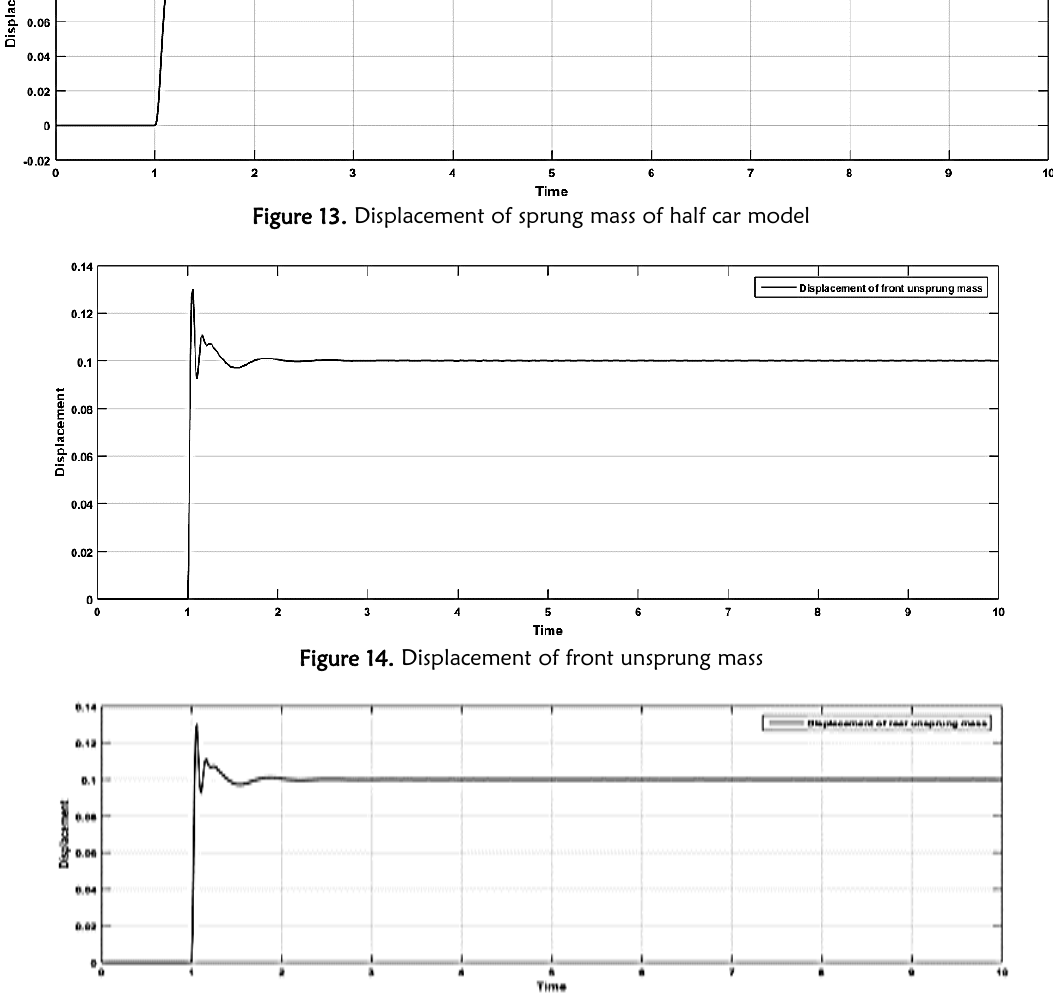
Figure 15. Displacement of rear unsprung